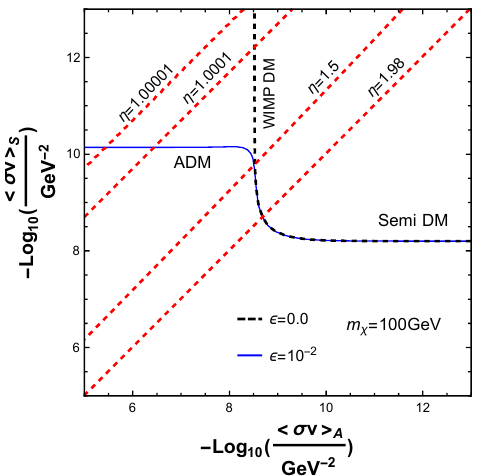
Figure 9 . Phase diagram showing the interplay between the semi-annihilation and pair-annihilation rates in determining the asymmetric DM properties. The observed relic abundance (cid:10) h 2 = 0 : 12 is satis(cid:12)ed, with and without CP-violation, along the blue solid and black dashed lines, respectively. The relative abundance parameter (cid:17) 2 represents the symmetric phase, while (cid:17) 1 represents the ! ! asymmetric phase. Here, ADM, Semi DM and WIMP DM denote the dominantly asymmetric dark matter, symmetric semi-annihilating DM and symmetric pair-annihilating DM phases, respectively. See text for